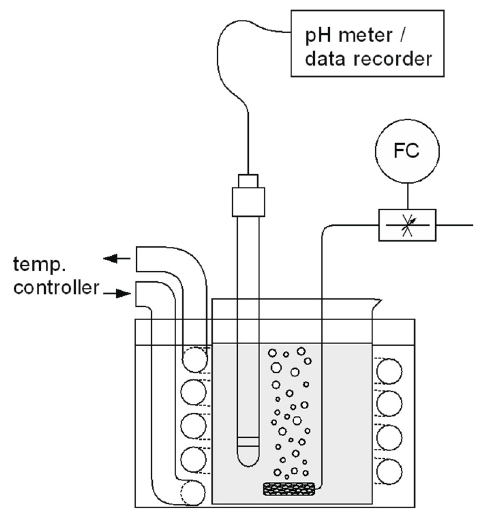
Figure 6. Experimental setup